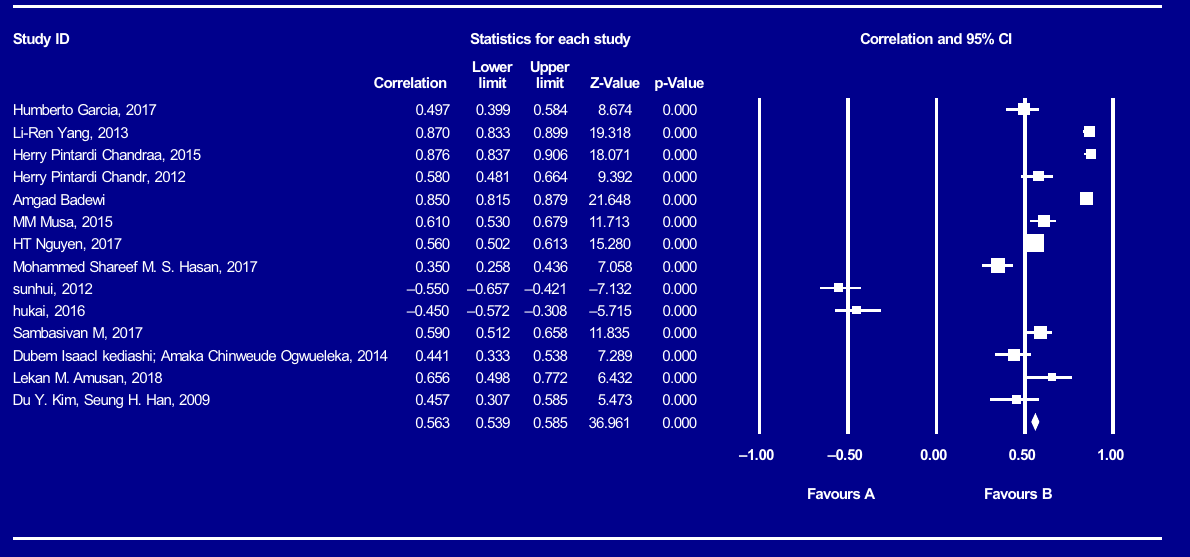
Figure A3. Results of meta-analysis (Cost)